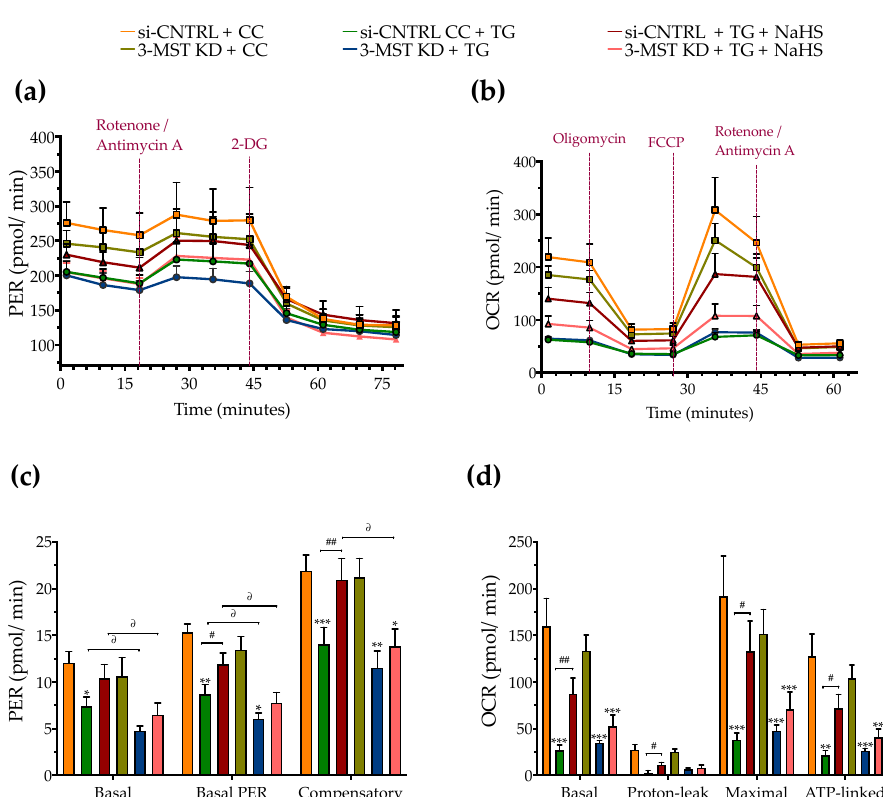
Figure 10. Effect of 3-MST silencing (knockdown; KD) on cellular bioenergetic function during ER stress. HepG2 cells previously subjected to 3-MST silencing (knockdown (KD)) or sham-silencing (si-CNTRL) were serum-starved for 8 h and treated with the vehicle or 100 nM of thapsigargin (TG), in the presence or absence of 100 µM NaHS for 16 h. We then monitored the proton efflux rate (PER) over the sequential injection of rotenone + antimycin A and 2-deoxy-D-glucose (20 mM) ( a , c ) and the oxygen consumption rate (OCR) over the sequential injection of oligomycin (1 µM; ATP synthase inhibitor), FCCP (1.5 µM; mitochondrial uncoupler) and of rotenone + antimycin A (0.5 µM; Complex I and III inhibitors) ( b , d ) with the Seahorse XFe24 Extracellular Flux Analyzer for assessing glycolysis and oxidative phosphorylation, respectively. Each graph line and bar represent mean ± SEM from four independent experiments. Data are expressed as a fold change of the sham-transfected control, vehicle-treated control conditions (si-CNTRL + CC). * p ≤ 0.05, ** p ≤ 0.01, and *** p ≤ 0.001 compared to corresponding CC; # p ≤ 0.05 and ## p ≤ 0.01, compared to the corresponding TG-treated cells; ∂ p ≤ 0.05 compared to the corresponding 3-MST KD treatment